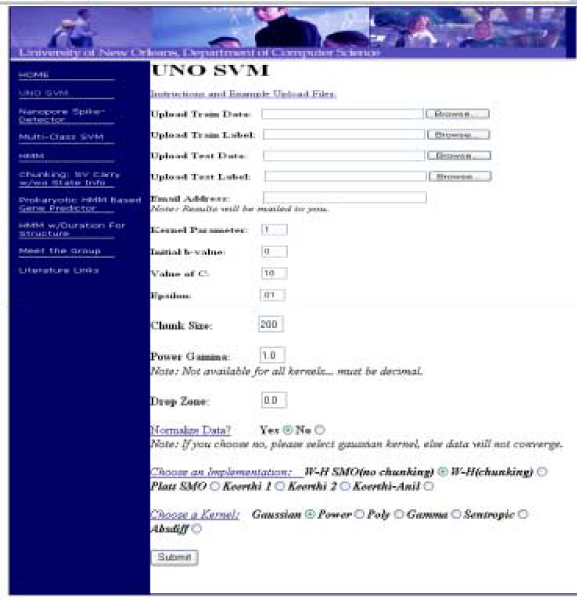
Several channel current cheminformatics tools are available for use via web interfaces at . These tools include a variety of SVM interfaces for classification and clustering (binary and multiclass), and HMM tools for feature extraction and structure identification (with applications to both channel current cheminformatics and computational genomics).